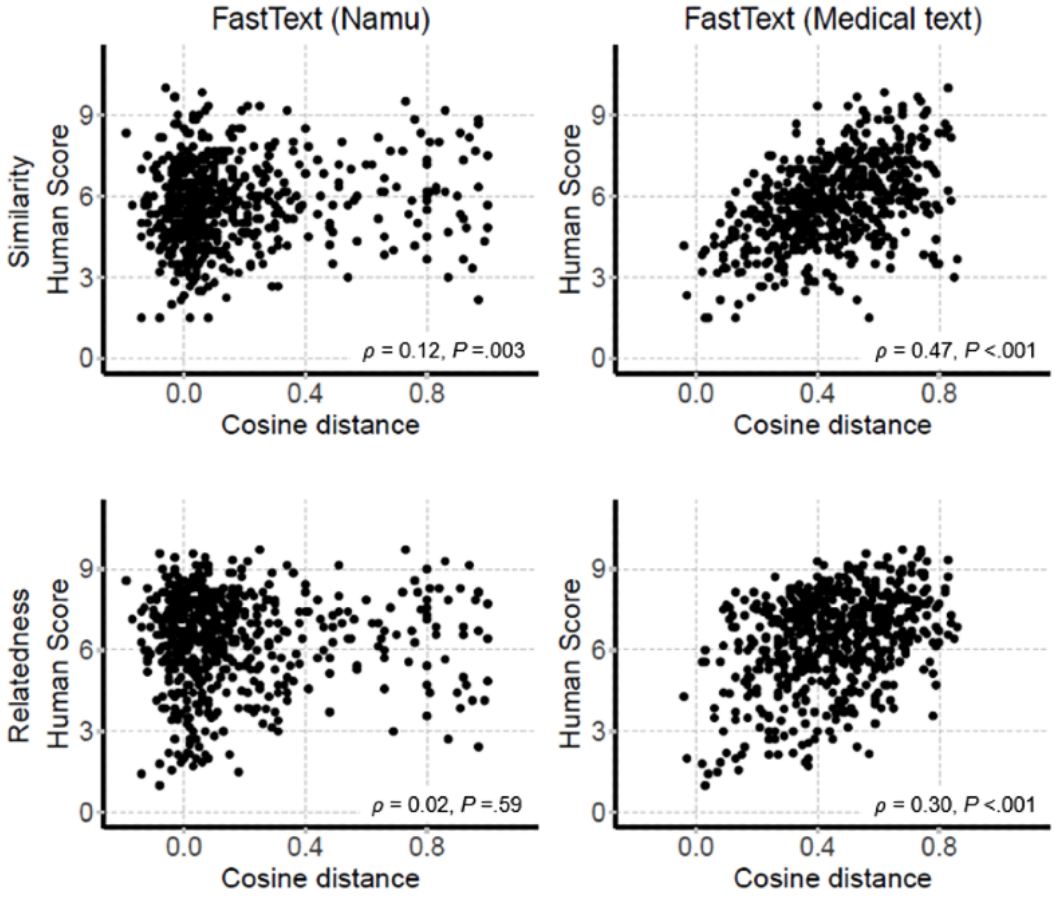
Figure 3. Correlation between cosine distance from FastText and the human evaluations from 13 attending